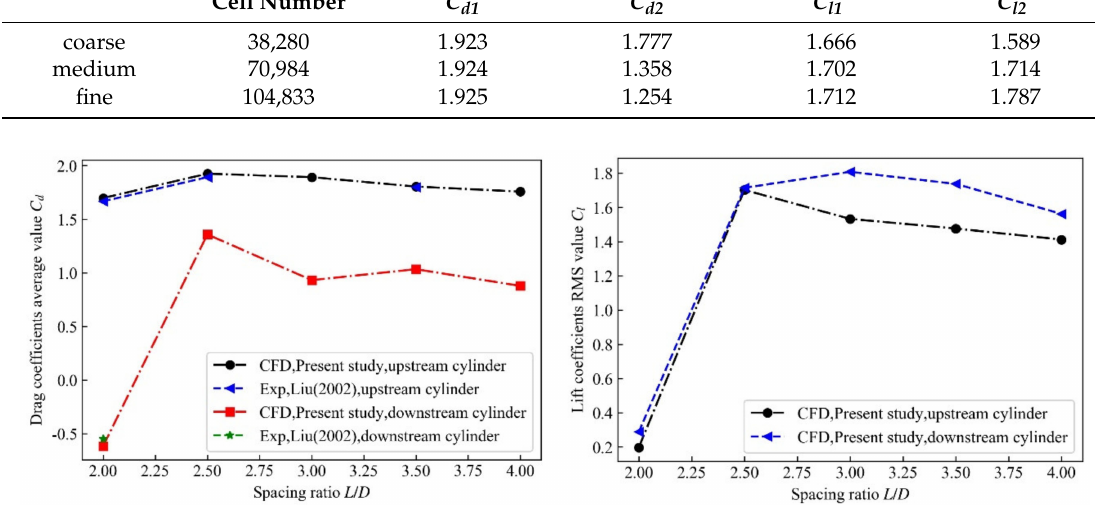
Figure 2. Force coe ffi cients of upstream and downstream square cylinders with di ff erent spacing ratios.